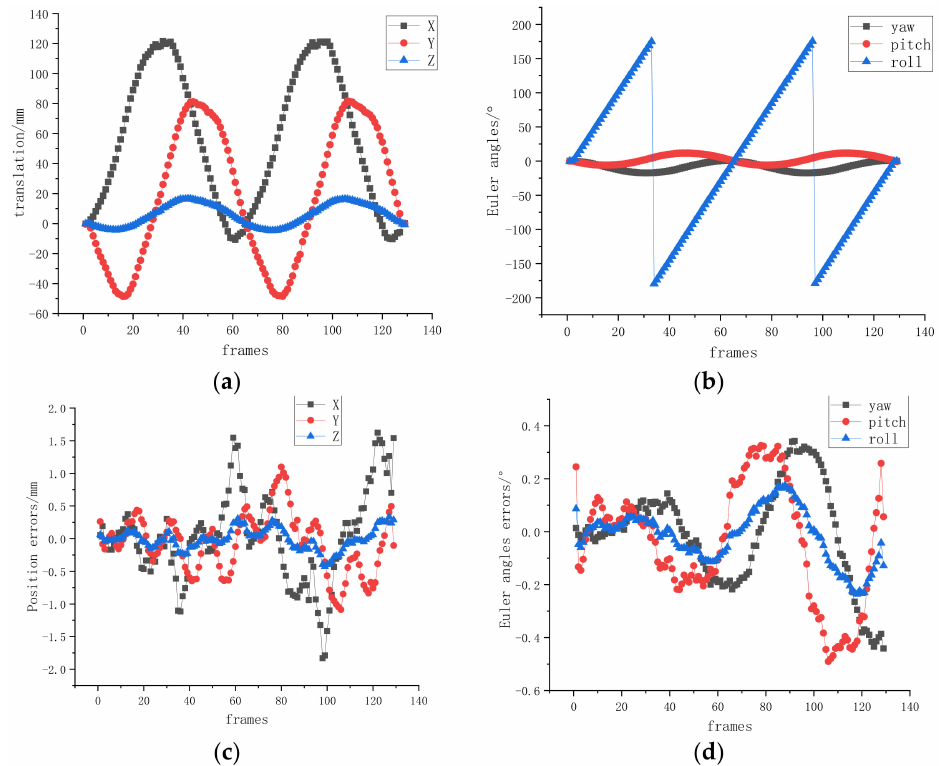
Figure 9. Pose-estimation results of our method for the rotation experiment. ( a ) Translation of the XYZ axis; ( b ) Euler angle RPY of the YZX axis; ( c ) Position errors of the XYZ axis; ( d ) Euler angles error of the YZX axis.